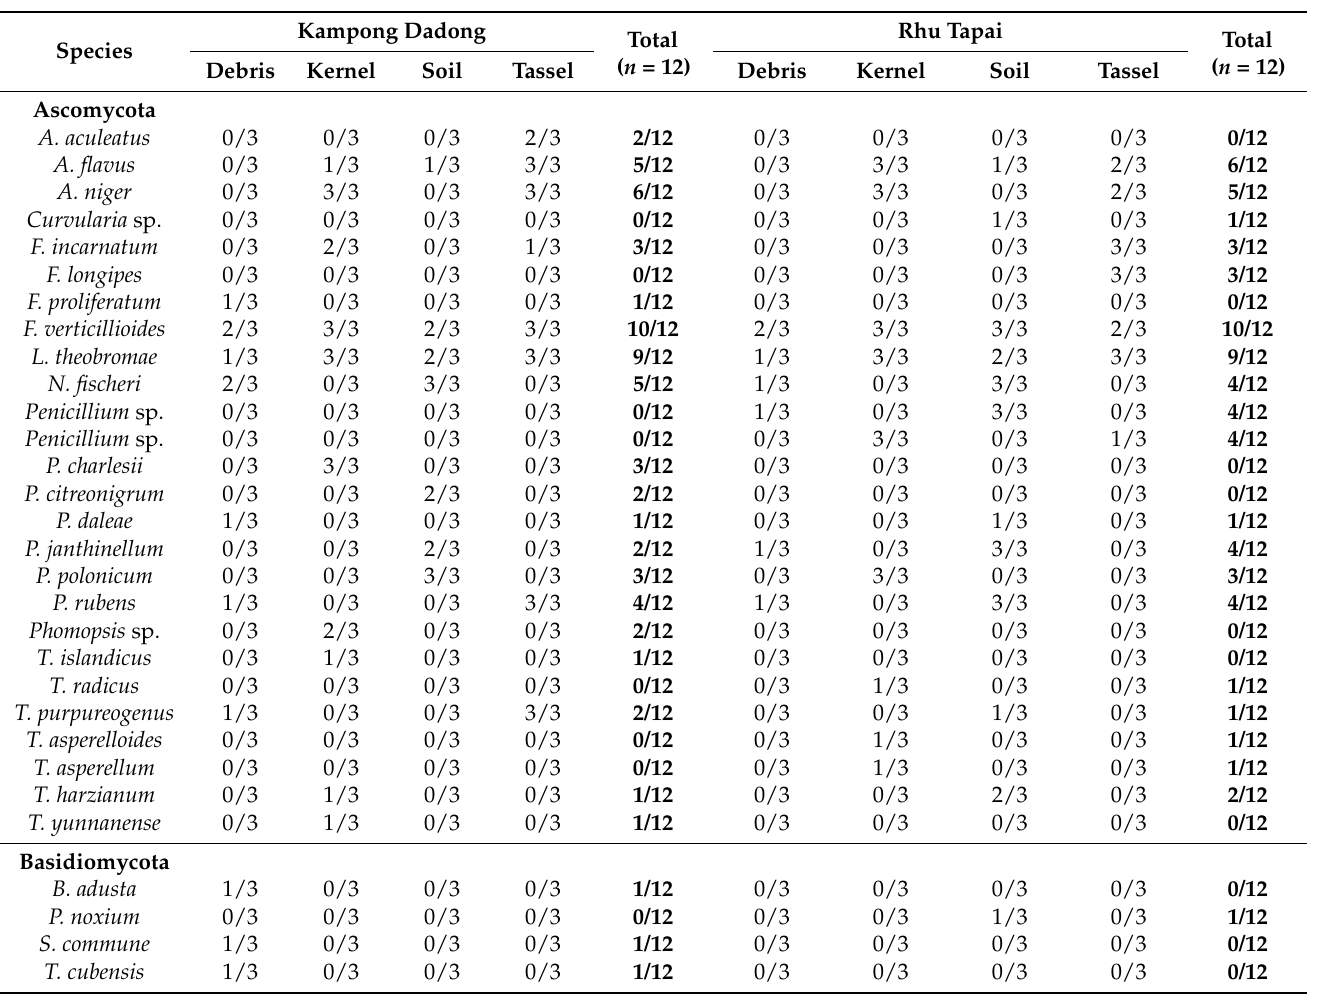
Table 3. Qualitative distribution of fungal isolates on debris ( n = 3), kernel ( n = 3), soil ( n = 3), and tassel ( n = 3) samples obtained from Kampong Dadong and Rhu Tapai grain corn farms in Terengganu. Species